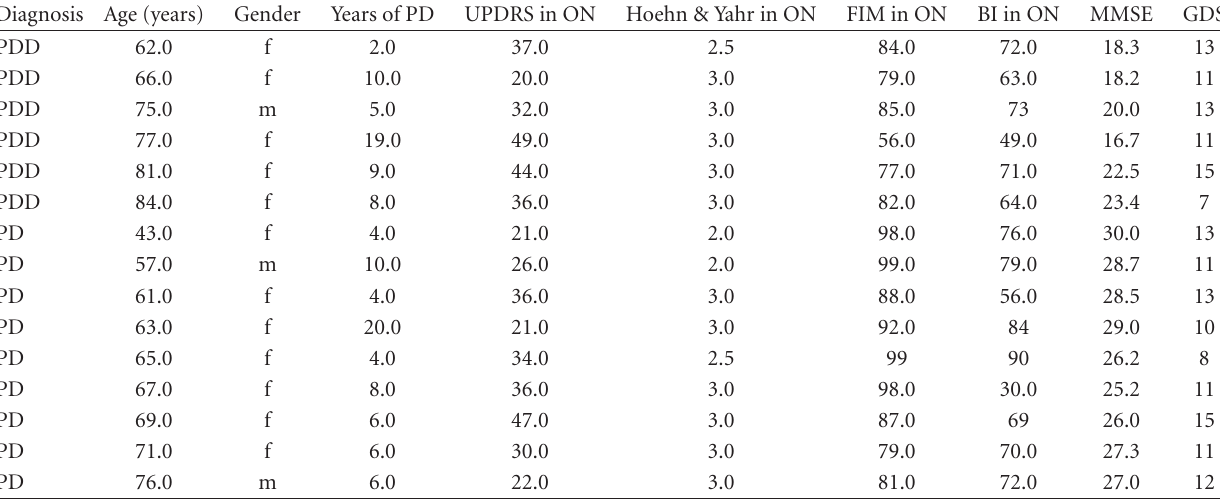
Table 1: Group of PD and PDD